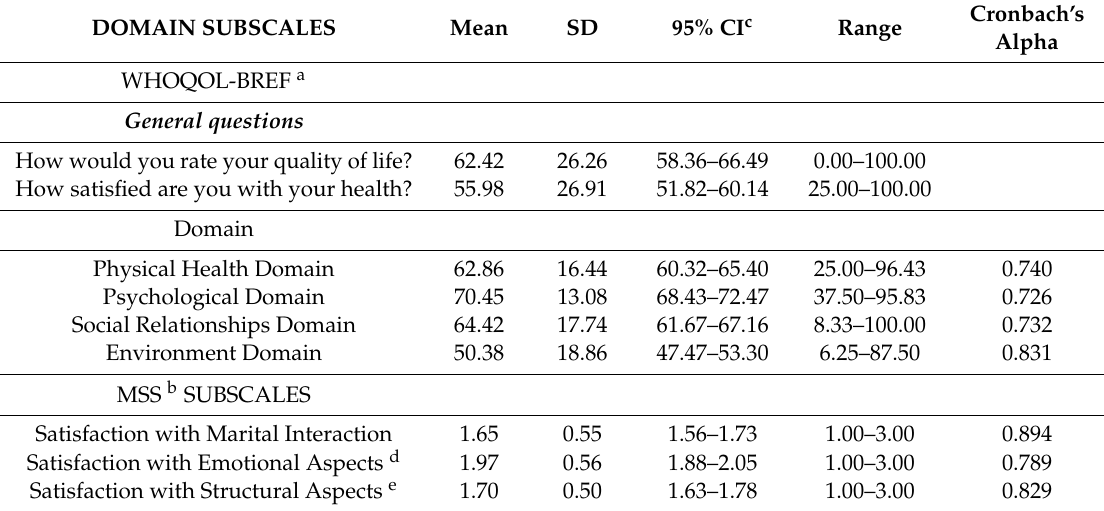
Table 2. Means, standard deviations (sd), minimum and maximum values, and Cronbach’s Alpha of scores of WHOQOL-BREF a domains and of ESC b subscales of family caregivers of patients with mental